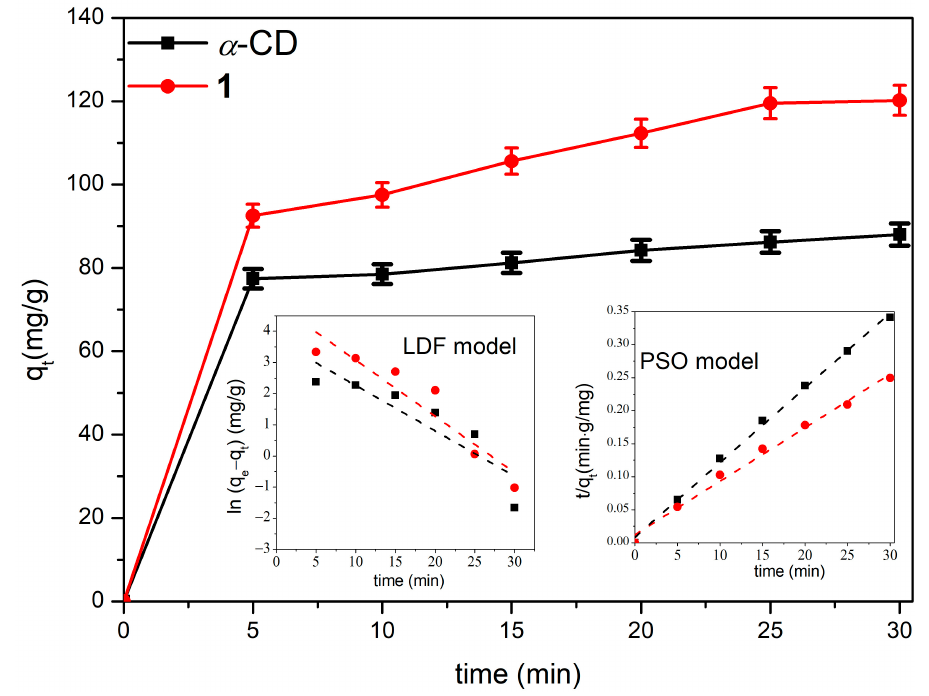
Figure 3. CO 2 capture kinetics on the samples of α -CD and 1 . In the insets, the experimental data (points) and the fit (dashed lines) with the LDF and the PSO models are shown.